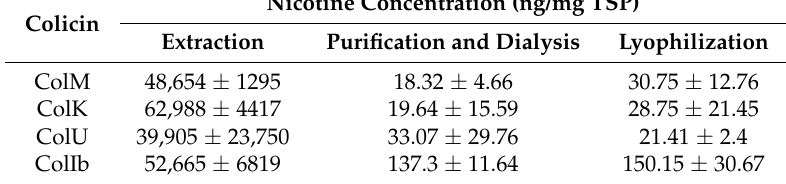
Table 5. Nicotine content of colicin-containing samples during and after purification. Colicin-containing samples of two batches were analyzed by HPLC-MS/MS for quantification of nicotine. Analysis was carried out for two batches of each